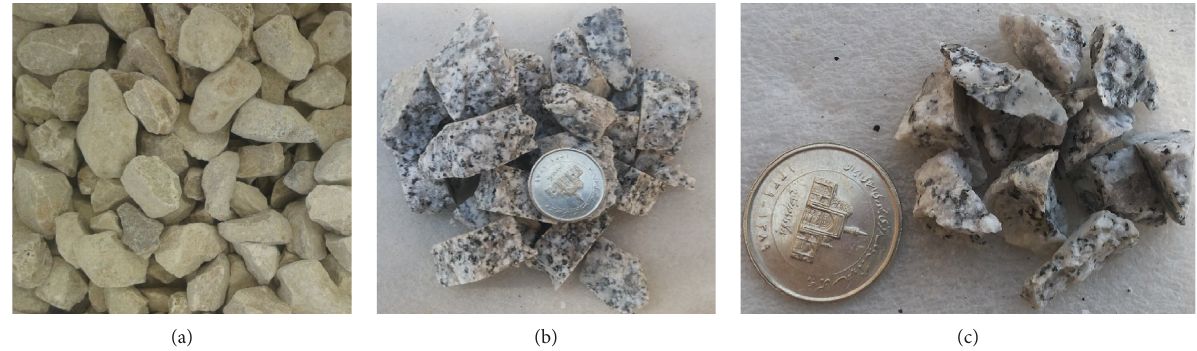
Figure 2: The used aggregates in the concrete samples. (a) Natural coarse aggregates. (b) Granite coarse aggregates. (c) The granite fine